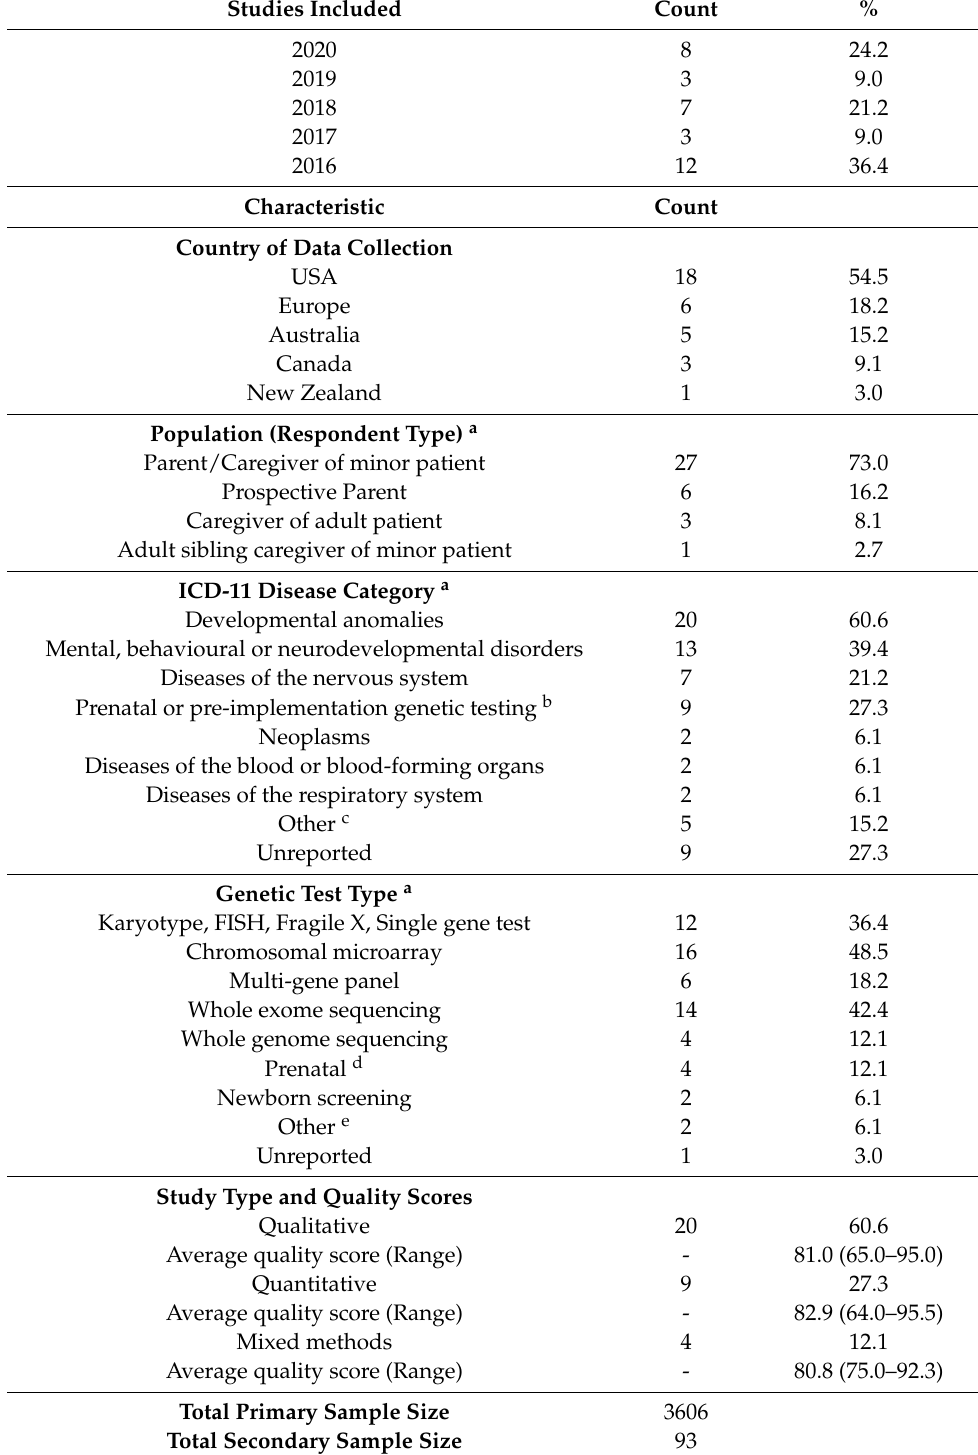
Table 1. Study characteristics ( n =